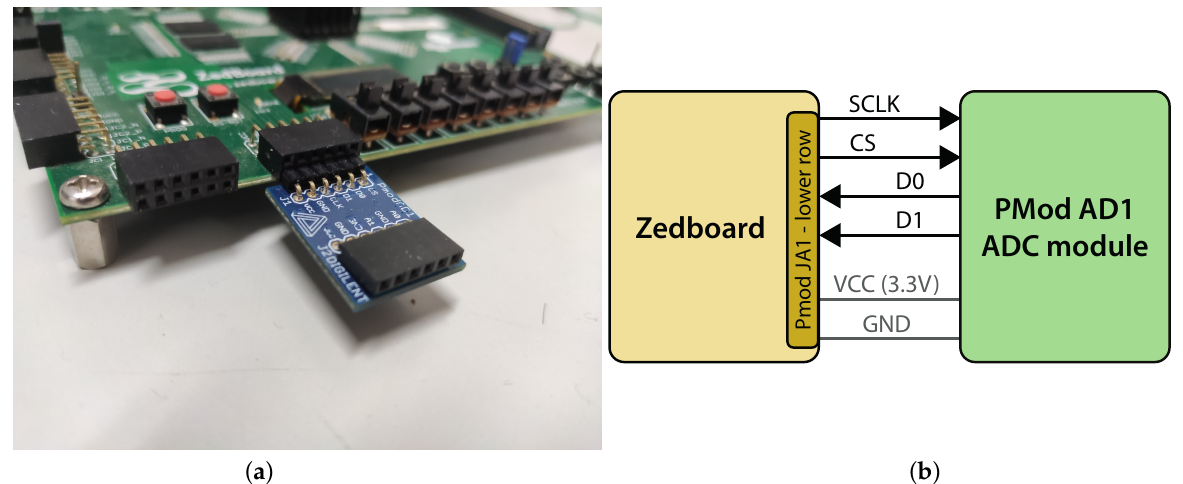
Figure 18. Pmod AD1 module installation for testing with the Zedboard and demo model. ( a ) Module assembly as used in the demo. ( b ) Schematic representation.